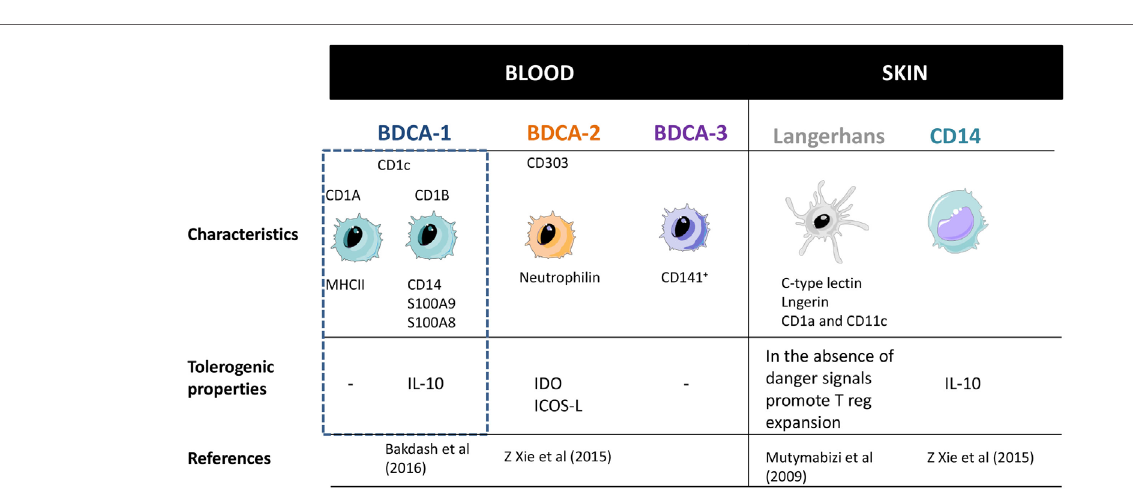
FigURe 3 | Dendritic cells subsets classification and their main properties. Adapted from: Cohn et al. (37). PRRs, pattern recognition receptors.